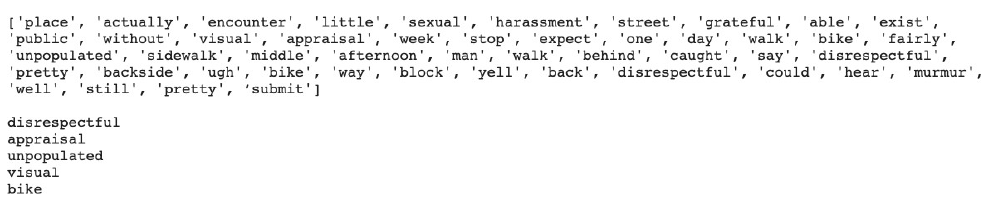
Figure 14. TF-IDF